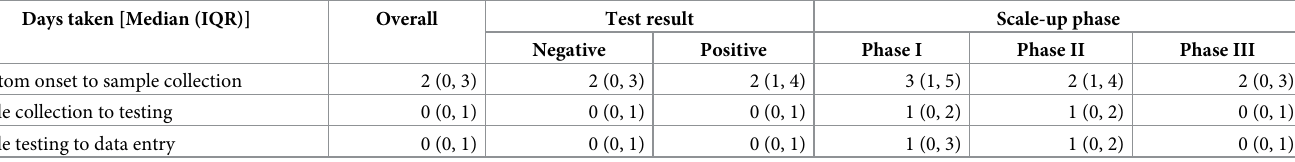
Table 3. Timeliness of the COVID-19 tests carried out in the laboratory surveillance network by scale-up phases and test results, India (March 2020 to January 2021). Days taken [Median (IQR)]